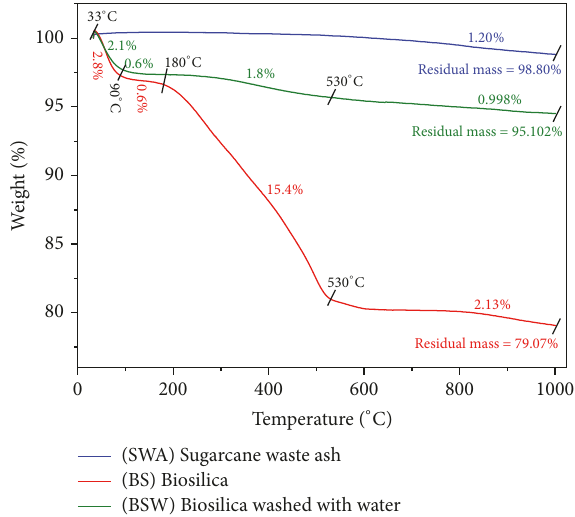
Figure 7: TG curves of SWA (blue), BS (red), and BSW (green) under an inert atmosphere of